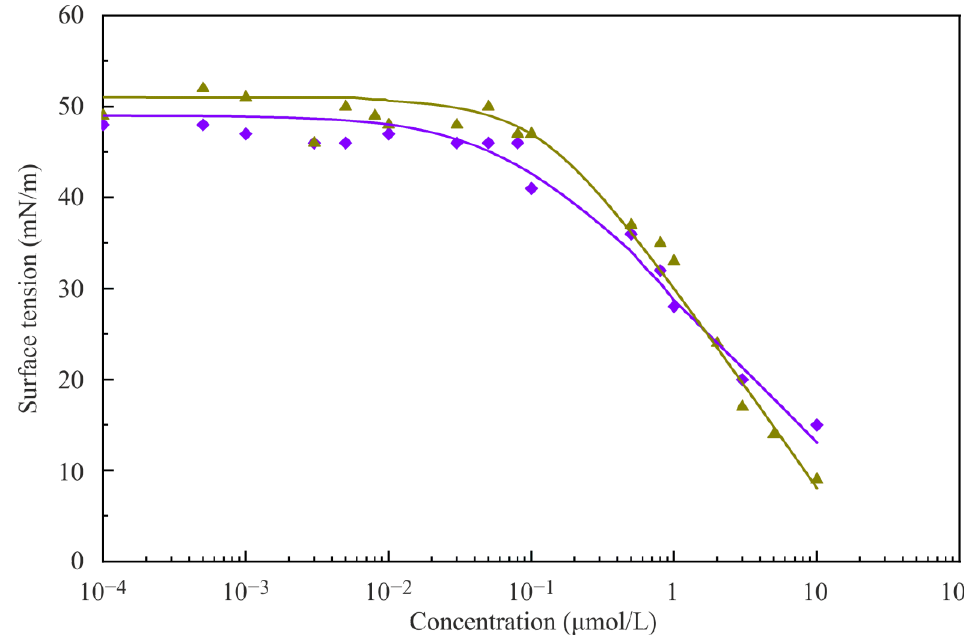
Figure 1. Equilibrium interfacial tension measured by profile analysis tensiometry (PAT) at the solution/hexane interface as a function of the total bulk concentration c of the mixtures: ( ) NaC 12 SO 4 + C 16 TAB and ( ) NaC 16 SO 4 + C 12 TAB; the solid lines are the fitting results for a Frumkin adsorption model given by Equations (1)–(3).